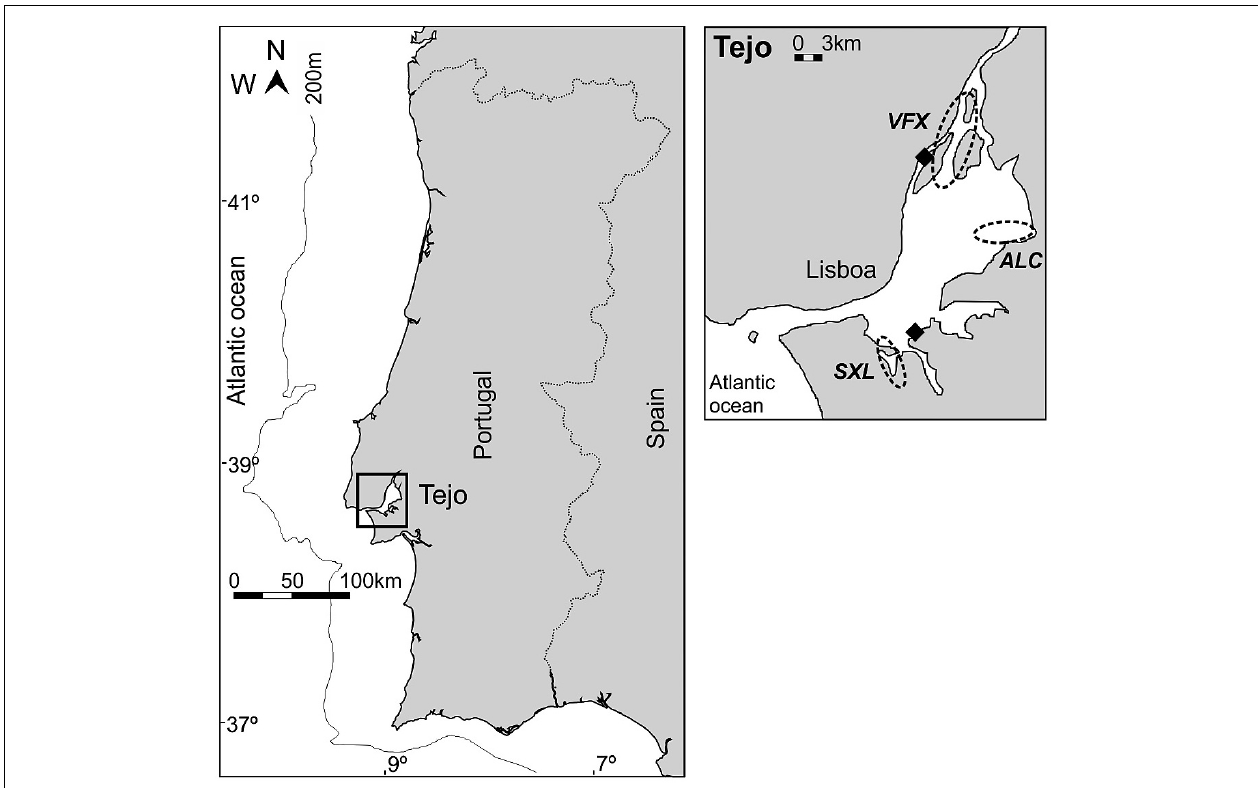
FIGURE 1 | Location of sites sampled within the Tejo estuary (ALC, Alcochete; SXL, Seixal; and VFX, Vila Franca de Xira). Mercury hotspots in the Tejo estuary are also represented (black squares), following Cesário et al.